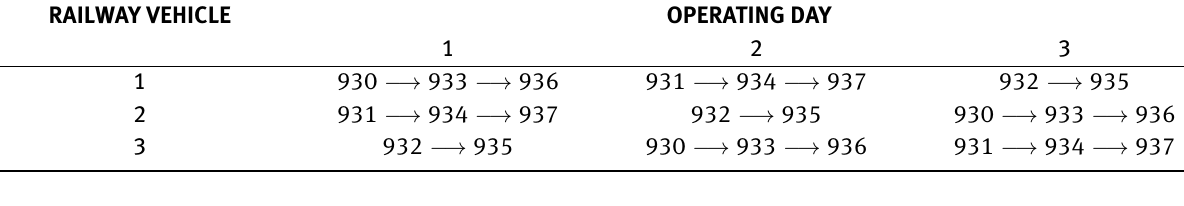
Table 2: Number of railway vehicles and their schedule (source: authors) RAILWAY VEHICLE